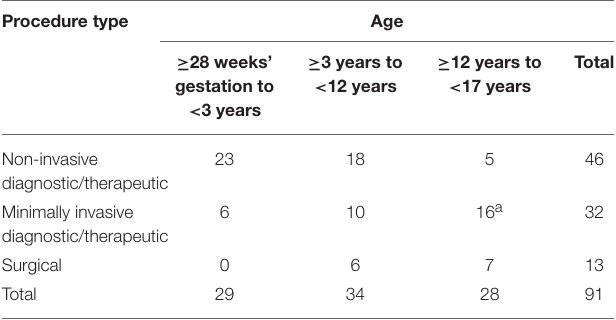
TABLE 2 | Patient enrollment by age group and type of